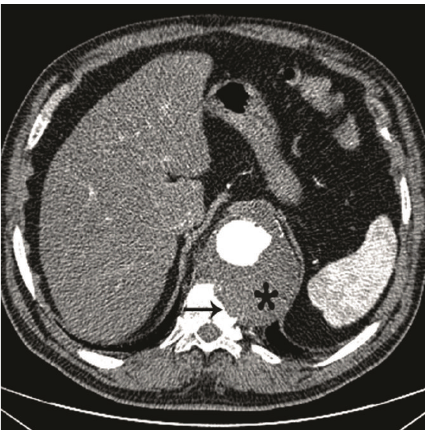
Figure 1: Contrast-enhanced axial multidetector CT angiography image obtained at the level of thoracal 11th vertebra reveals chronic- contained aneurysm rupture of the aorta ( ∗ ) with vertebral erosion and lysis. Draped aorta sign is present (arrow).